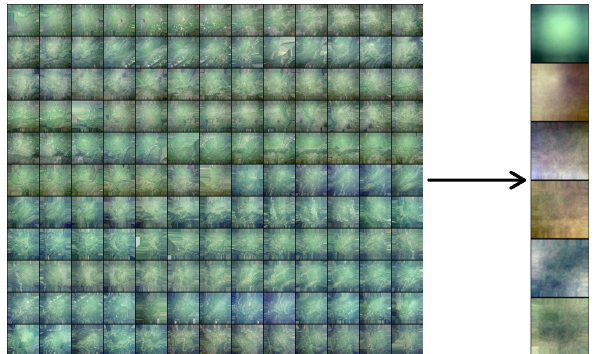
Figure 6. Karhunen-Lo`eve transform.